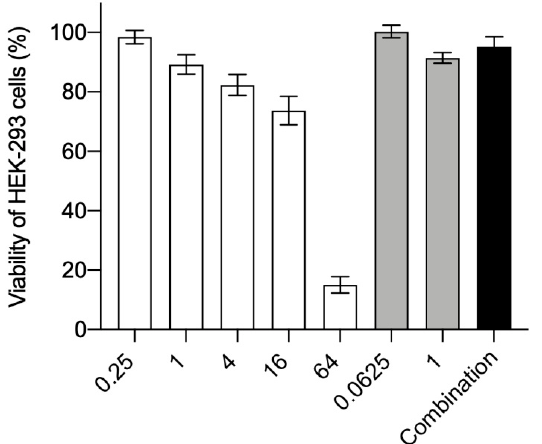
Figure 2. Effect of CSDP + and fluconazole on the viability of HEK-293 cells. The cells were treated with CSDP+ (white bars), fluconazole (grey bars), and their combination (0.0625 µ g/mL of fluconazole and 0.25 µ g/mL of CSDP + , black bar). Data are shown as mean ± standard deviation (SD). The level of 100% corresponds to the viability of HEK-293 cells not treated with any compound.